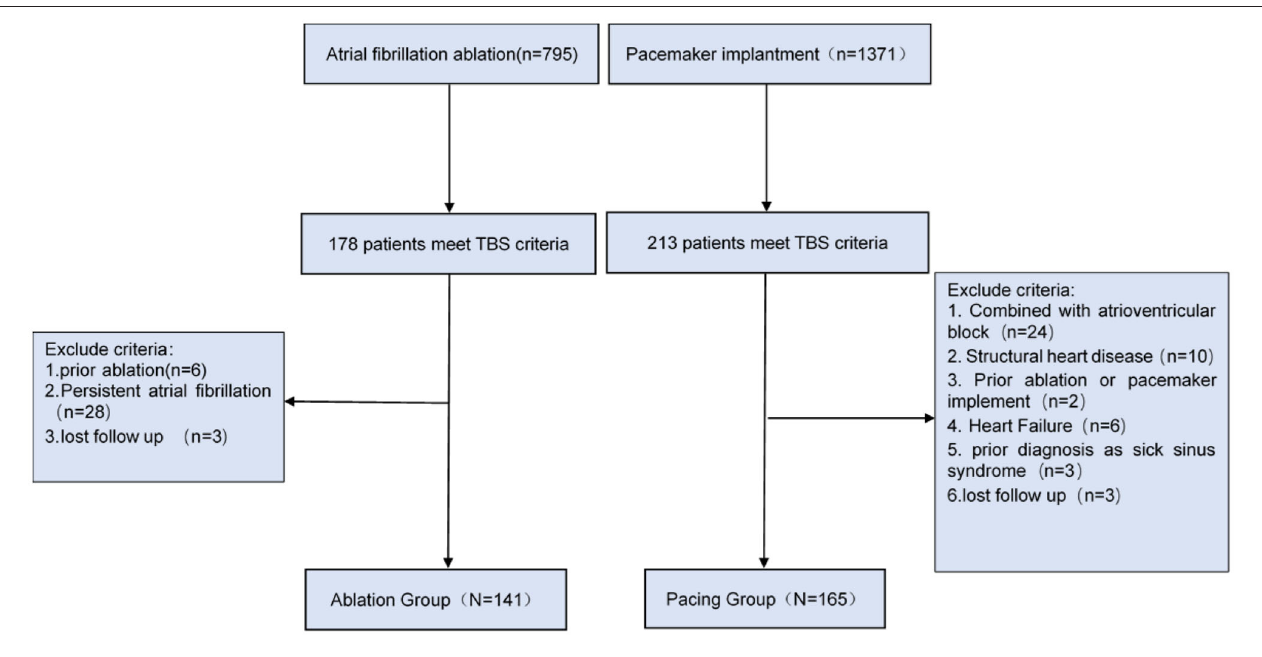
FIGURE 1 | Study population and flow chart.